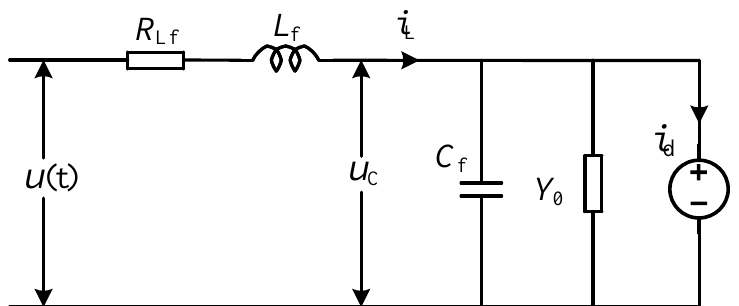
Figure 4. Topology of three-phase Z-source inverter.